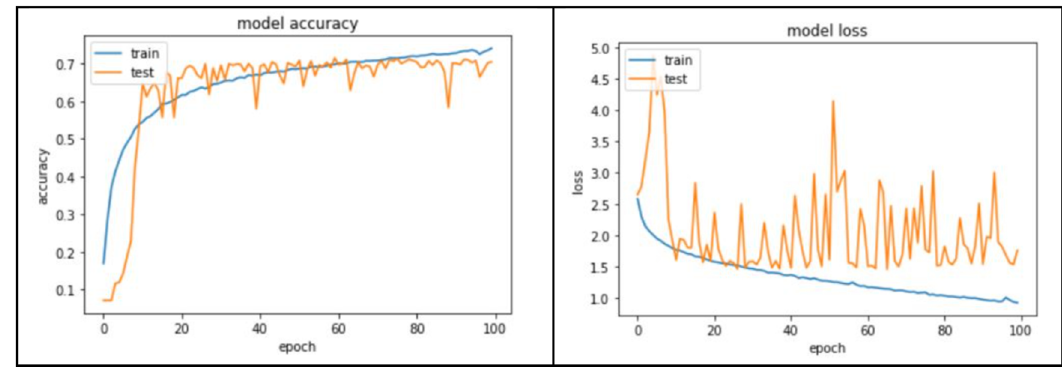
Figure 5: Analysis of the CNN